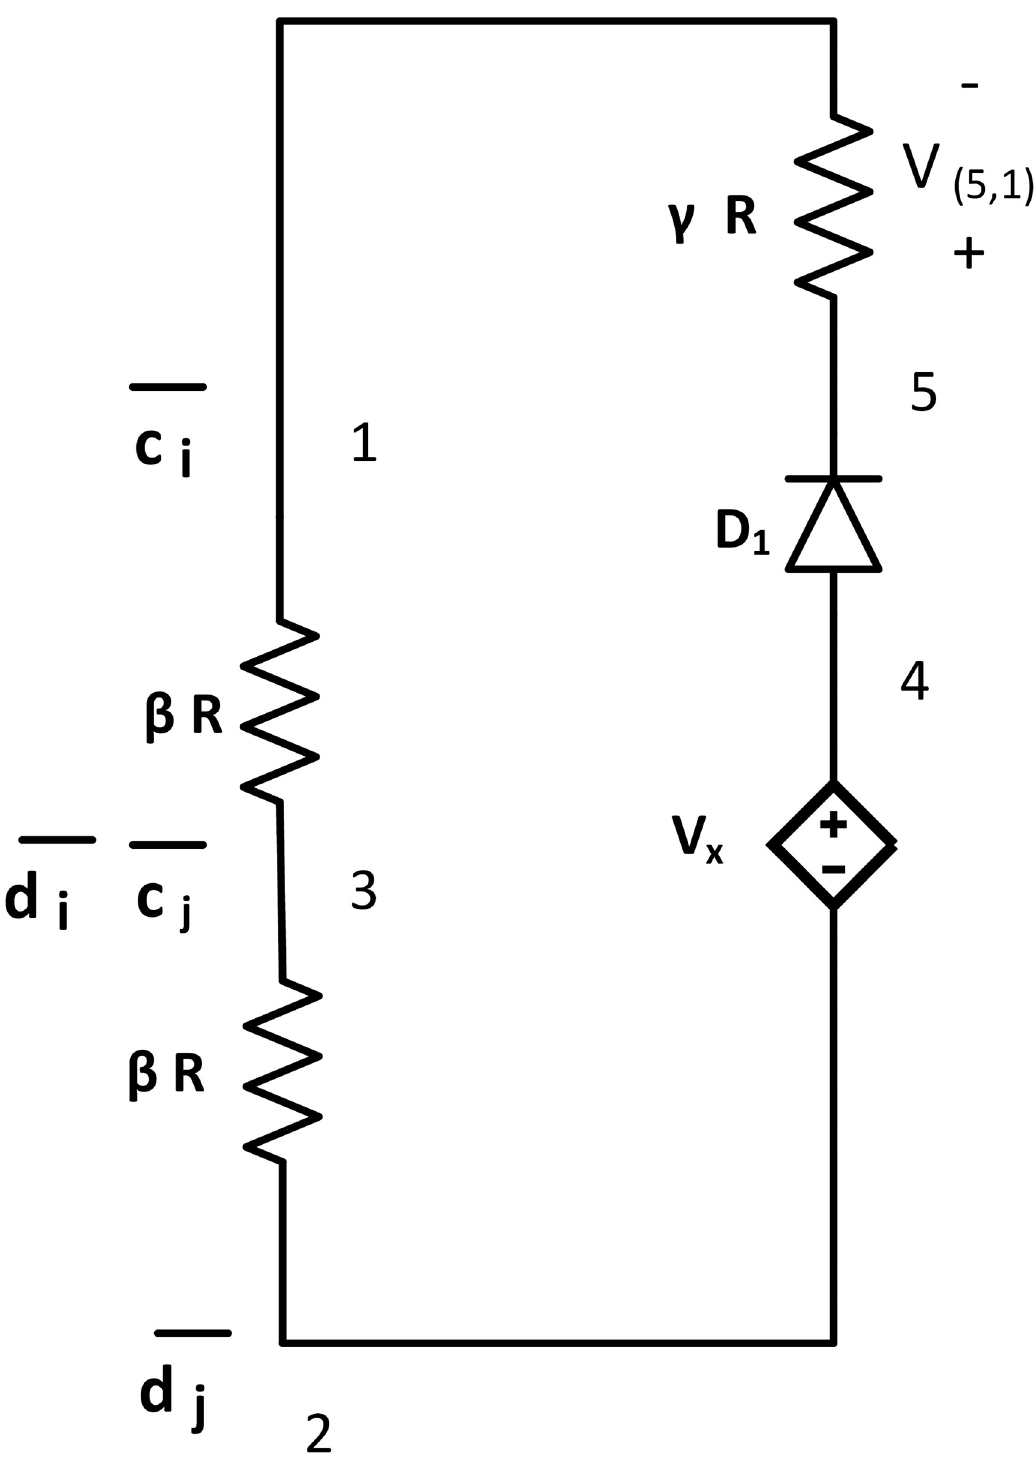
Fig 7. NOR tile. NOR tile has three resistors (two β R resistors, and γ R resistors where γ > > β > > R ), one ideal diode D 1 with zero threshold voltage, and one dependent voltage source V has an output node at {5, 1}. Glues: g ð 1 Þ ¼ f � c